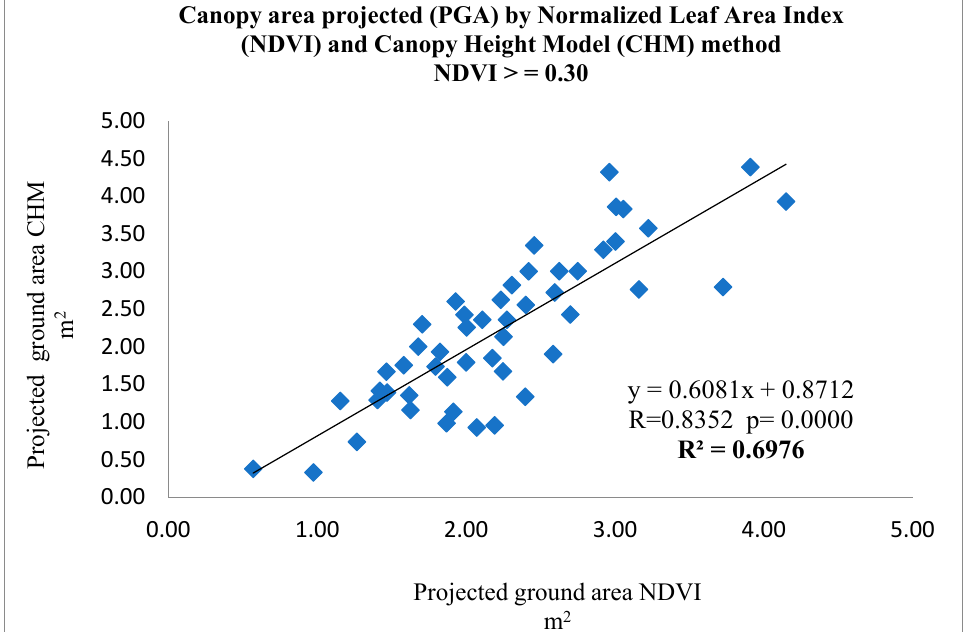
y = 0.6081x + 0.8712 R=0.8352 p= 0.0000 R² = 0.6976